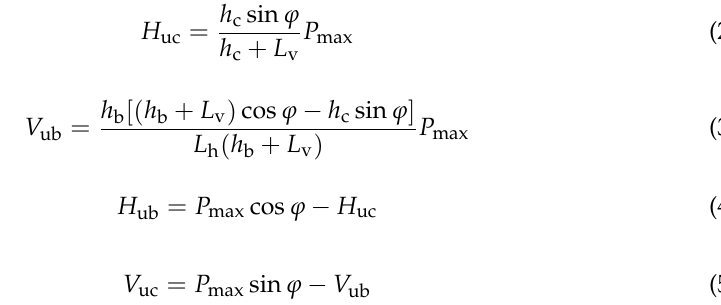
Figure 3. According to the force equilibrium requirement for the gusset plate, the gusset-